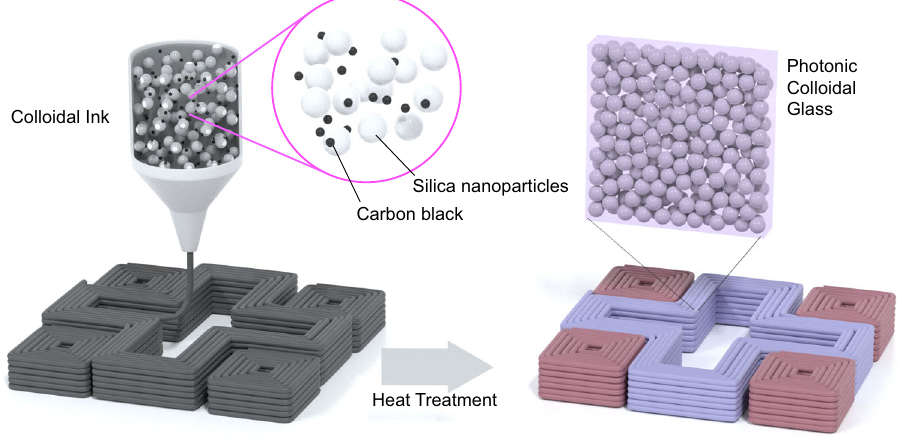
Fig. 1 | The printing platform. Schematics illustrating the 3D printing of colloidal inks into objects with isotropic structural color. Coloration is generated by photonic colloidal glasses obtained upon complete drying of the as-printed objects.